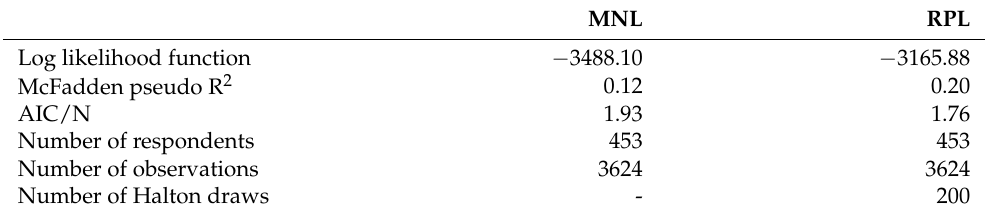
Table 11. Multinomial logit (MNL) model and random parameter logit (RPL) model parameters.